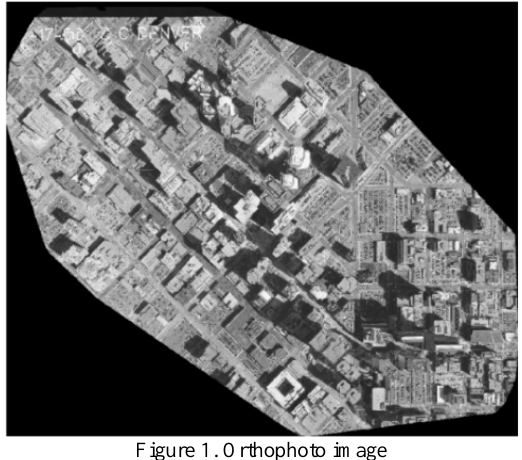
Figure 1. Orthophoto image